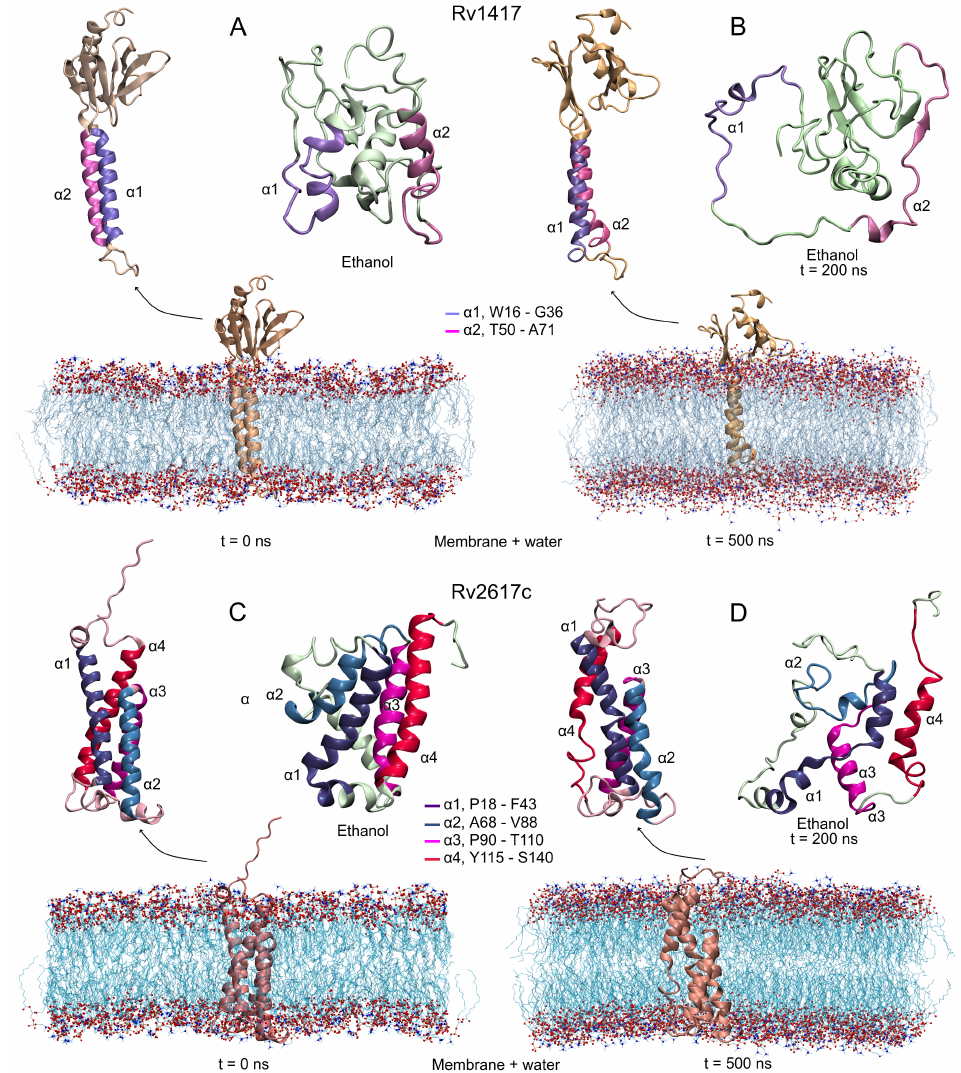
Figure 2. Initial and final structures obtained in the MD simulations. Protein systems were simulated under two different conditions: protein–membrane in water solvent and in semi-polar (ethanol as solvent) environments. ( A , B ) Rv1417, and ( C , D ) Rv2617c. Transmembrane alpha-helices are highlighted in all structures. MD simulations were carried out at 309.15 K and 1 bar